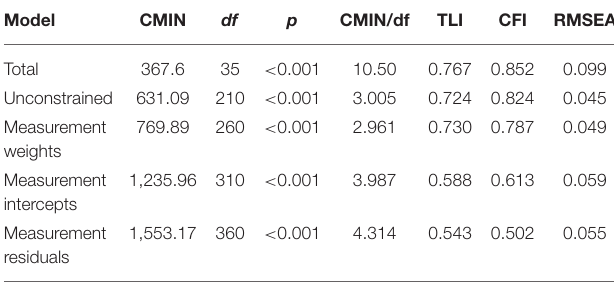
TABLE 9 | Measurement invariance of the UNAI-scale across